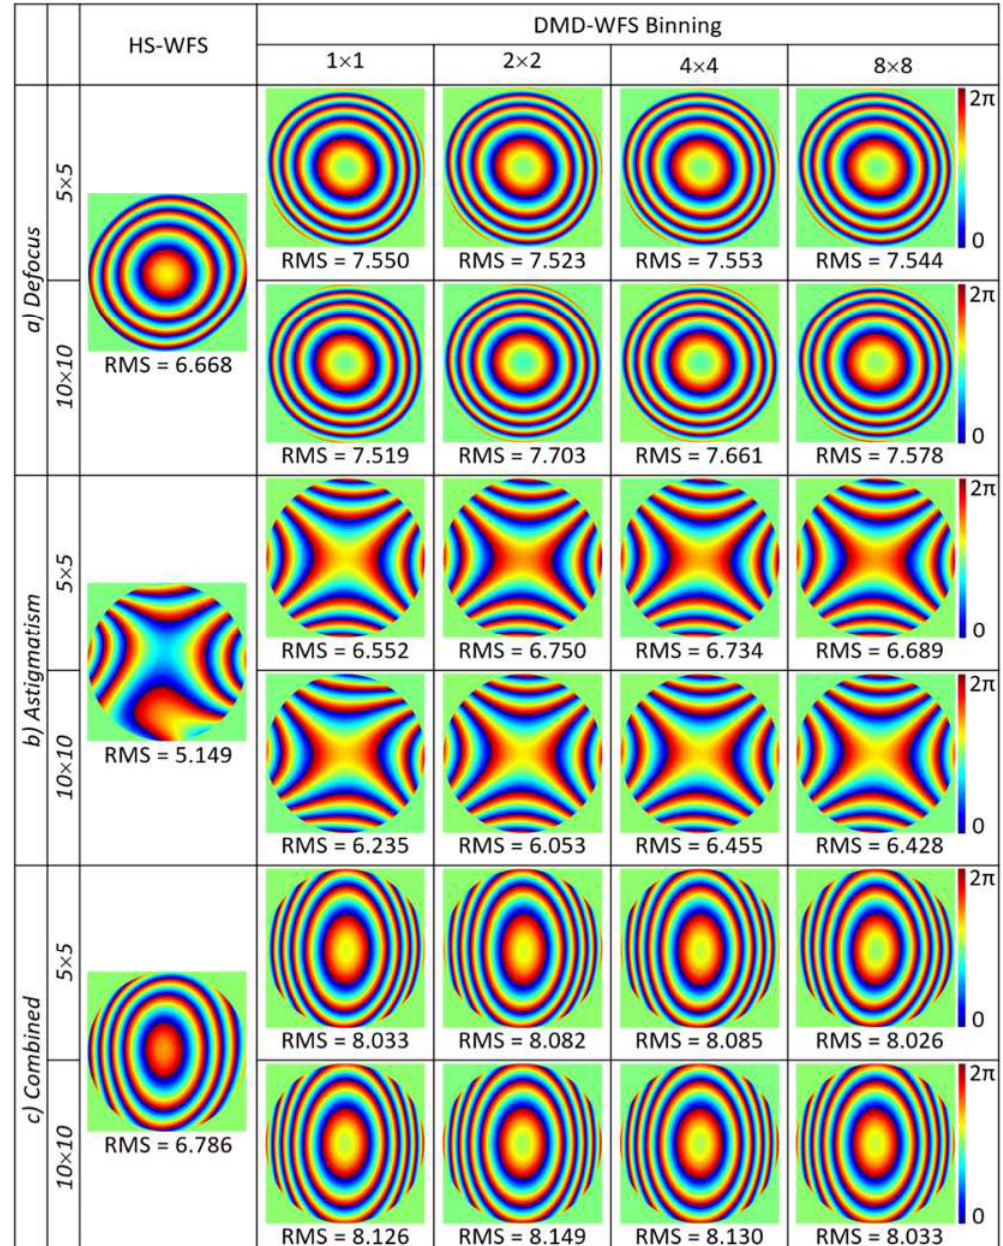
Figure 4. Comparison of defocus and astigmatic wavefront reconstructions for a 4 mm pupil with an artificial eye through Zernike coefficients between HS wavefront sensing, and for the DMD wavefront sensing method with four different binning options in the CCD camera, acquiring the PFS images for each DMD cell. All RMS values of the Zernike coefficients are given in μm.